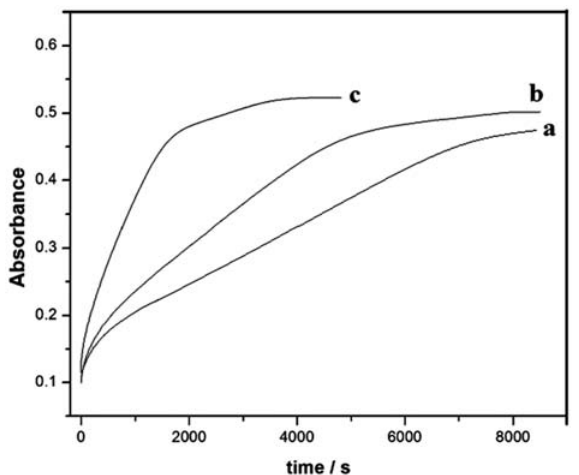
Fig. 5. Plot of absorbance vs. time for reaction of Cu(bcen)(NO (6.50 × 10 –3 M) and teazma, a = 6.50 × 10 –3 M, b = 9.8 × 10 –2 M, c = 1.63 × 10 –1 M recorded in DMF solvent.